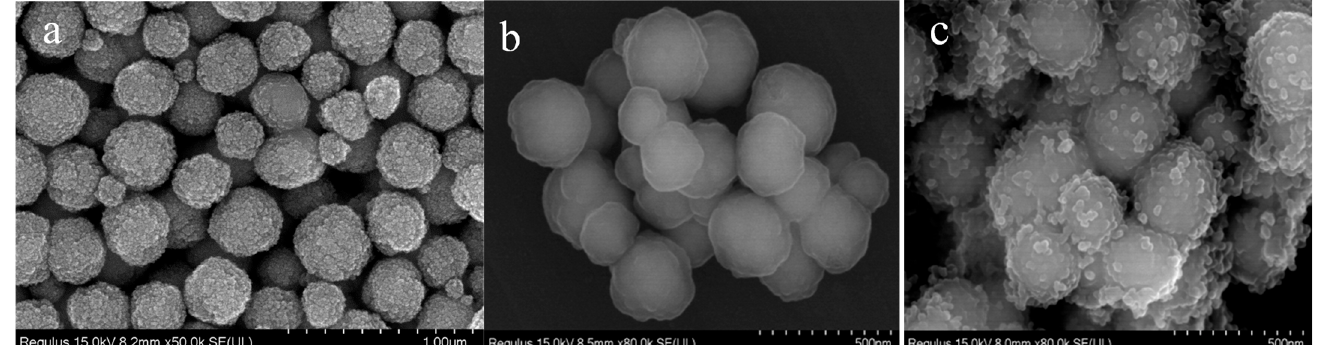
Figure 1. SEM images of Fe 3 O 4 ( a ), Fe 3 O 4 @SiO 2 ( b ) and Fe 3 O 4 @SiO 2 @N(CH 3 ) 3+ ( c ). Figure 2a shows the FT-IR spectra of Fe 3 O 4 , Fe 3 O 4 @SiO 2 , and Fe 3 O 4 @SiO 2 @N(CH 3 ) 3+ , respectively. For all the microspheres, a peak at 585 cm − 1 corresponded to the Fe-O stretch- ing vibration.[23] The peaks located between 1000 and 1250 cm − 1 , as well as those at 798 cm − 1 , assigned to the stretching mode of Si-OH and Si-O-Si in silica [24], respectively, in- dicating that the silicon layers were successfully coated on the surface of Fe 3 O 4 by the sol- gel method. In addition, a new peak at 1479 cm − 1 is assigned to the asymmetric bending nary ammonium in the Fe 3 O 4 @SiO 2 @N(CH 3 ) 3+ [20,25]. Meanwhile, the declining peak in- tensity of Fe-O and Si-O-Si in Fe 3 O 4 @SiO 2 @N(CH 3 ) 3+ demonstrates the successful aggrega-